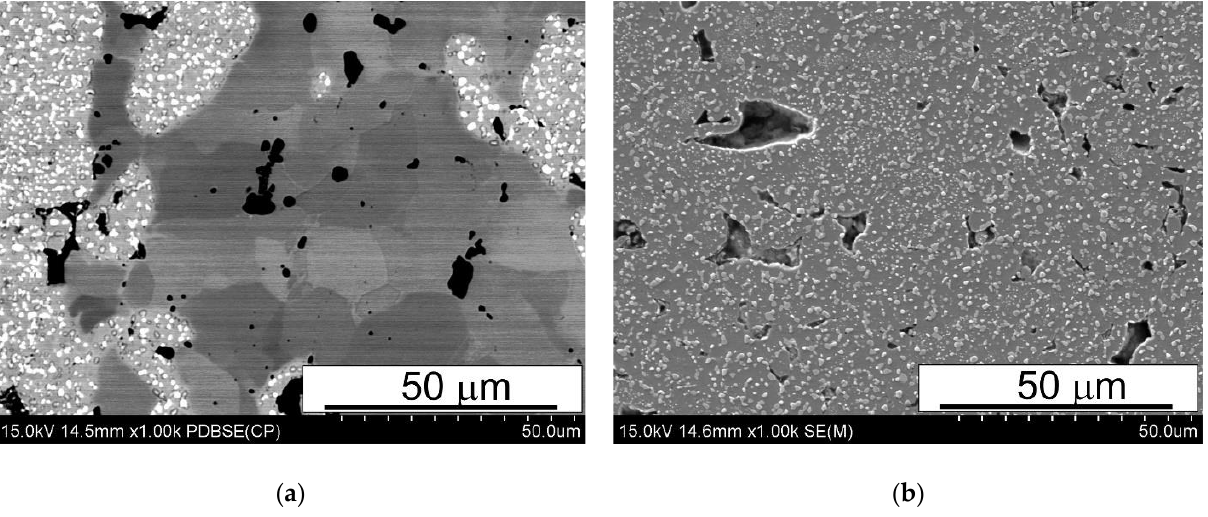
Figure 7. Microstructures of ( a ) T15+50%Fe and ( b ) T15 materials spark plasma sintered at 1000 °C; SEM.